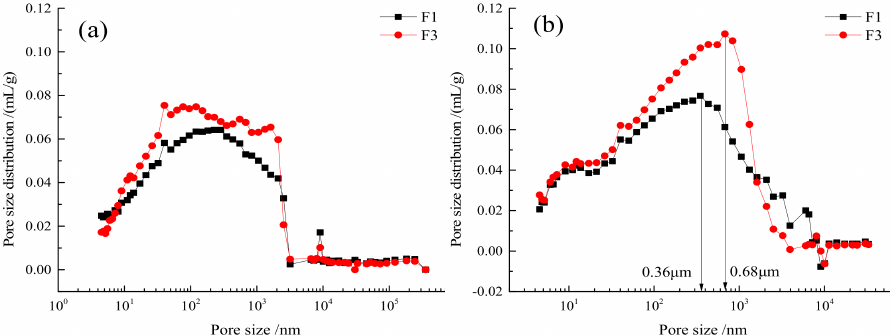
Figure 9. Relationship between differential mercury compression and pore size of the filler at different maintenance ages of F1 and F3 groups with high fly ash content: ( a ) 7 d, ( b ) 28